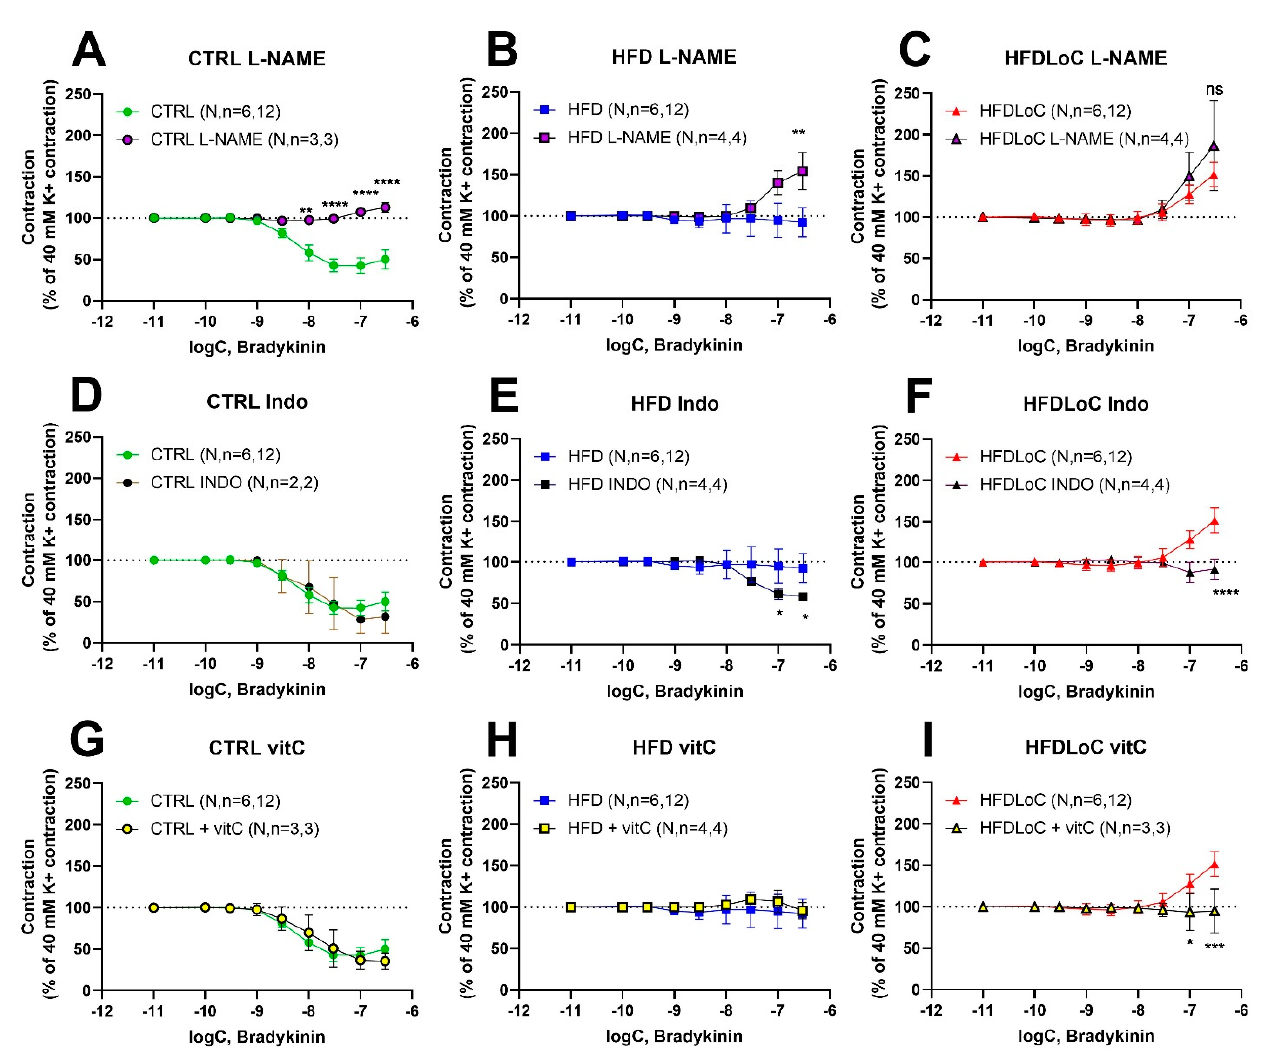
Figure 4. Concentration–response curves to bradykinin obtained in the absence or ( A – C ) presence L-NAME (10 µ M), ( D – F ) indomethacin (10 µ M), and ( G – I ) vitC (75 µ M L-ascorbic acid and 100 µ of L-NAME (10 µM), ( D – F ) indomethacin (10 µM), and ( G – H ) vitC (75 µM L-ascorbic acid and 100